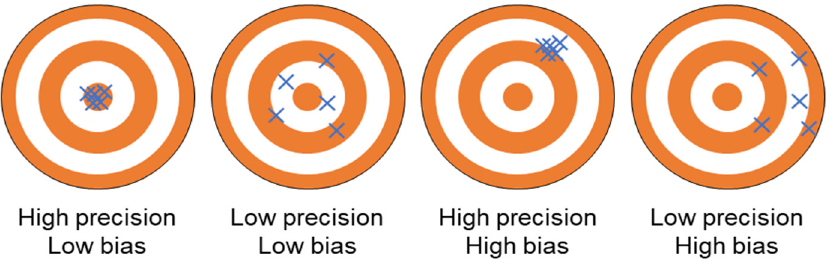
Figure 3. Sensor error component.